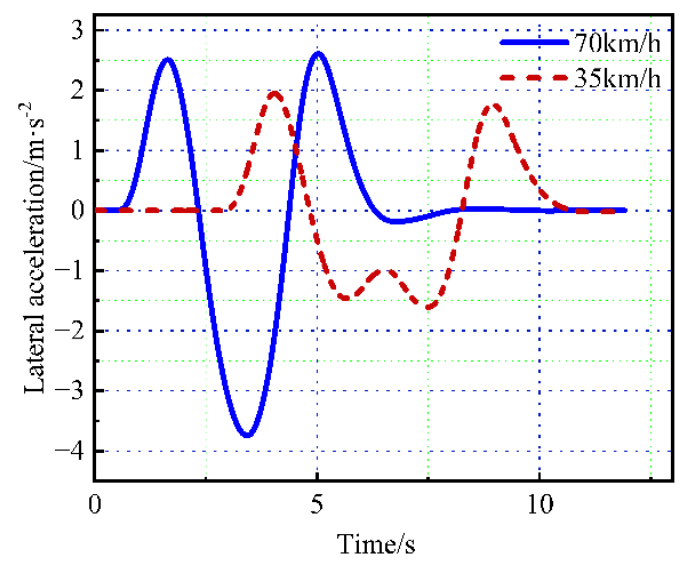
Figure 11. Variation curve of vehicle lateral acceleration.